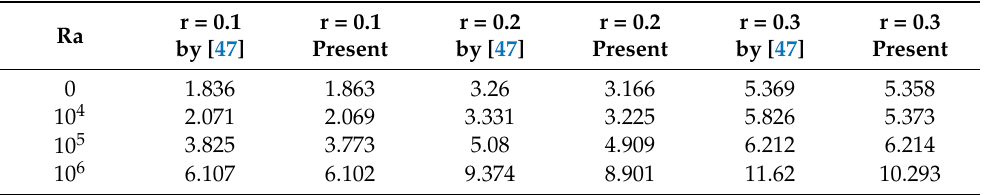
Table 4. Comparison of Nu avg with the results reported by Moukalled and Acharya [47] for viscous case ( φ hnf = 0) at different Rayleigh number and